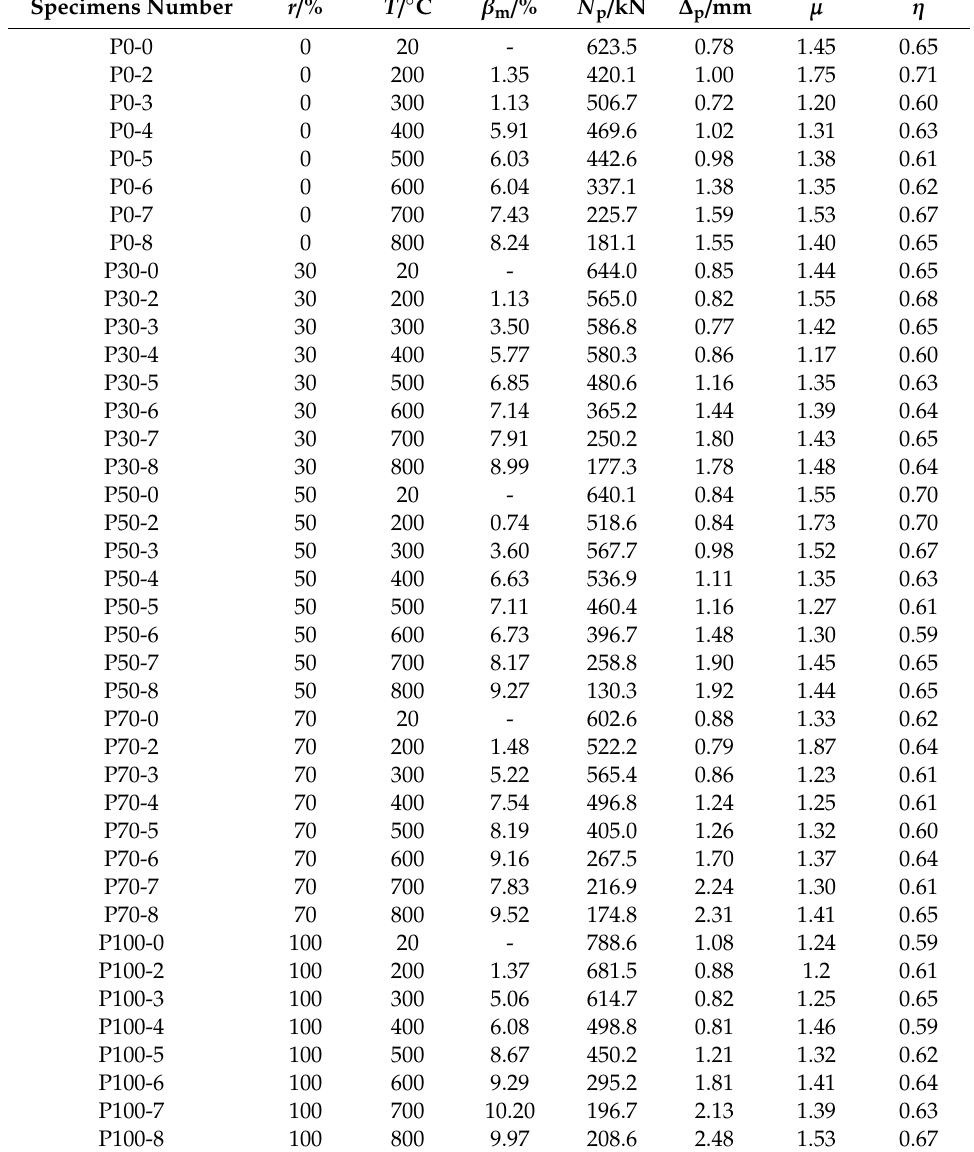
Table 2. Design parameters and experimental results of prism